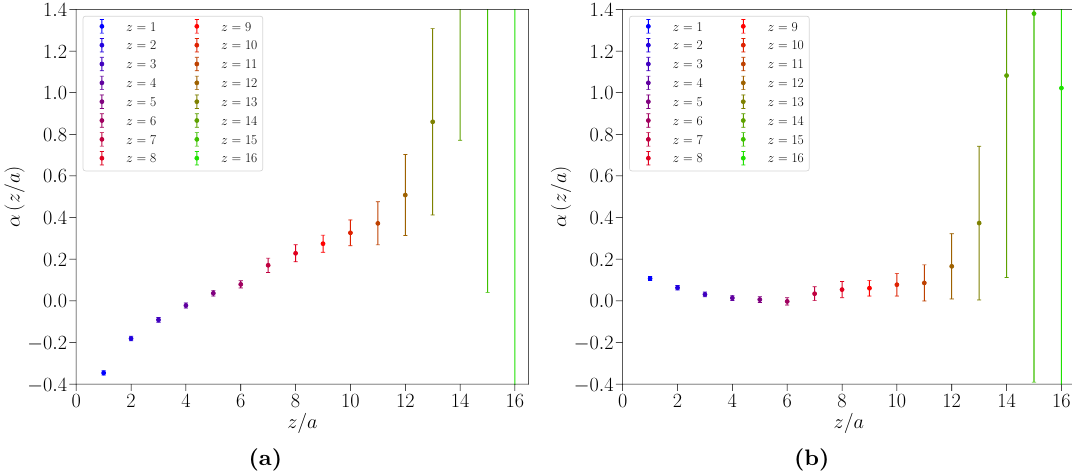
Figure 26. (a) The variation of α with z/a resulting from the cosine-transform of the model pseudo- PDF in eq. (5.1) fit to Re M 0 (cid:0) ν, z 2 (cid:1) for each z 2 . The discretization effect captured by the optimal Jacobi polynomial expansion { n = { 4 , 1 , 3 , 2 } is subtracted from Re M (cid:0) ν, z 2 (cid:1) lt , n az , n t 4 , n t 6 } v v prior to performing each fit. (b) The variation of α with z/a resulting from the cosine-transform of the two-parameter PDF form in eq. (5.1) fit to the discretization corrected and matched ITD Re Q 0 (cid:0) ν, z 2 (cid:1) for each z 2 . The discretization corrected ITD is considerably more independent of the interval z 2